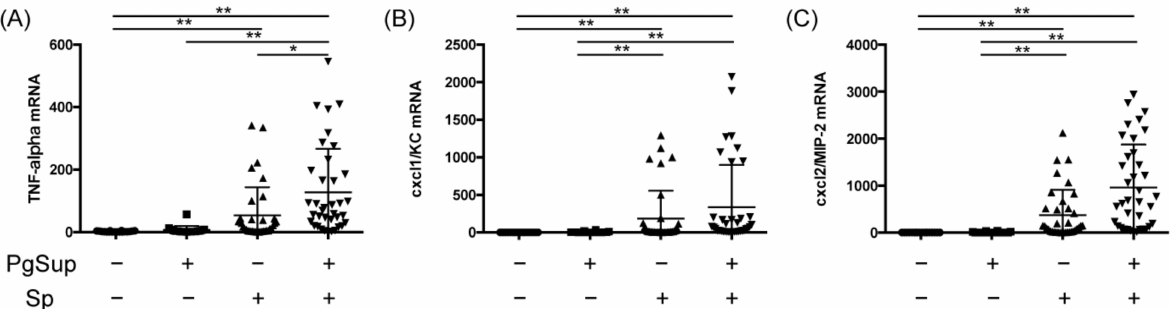
Figure 4. The mRNA expression of TNF- α , CXCL1 , and CXCL2 in Sp-infected mice inoculated with or without PgSup. Lung homogenates from each group were analyzed to compare ( A ) TNF- α , ( B ) CXCL1 , and ( C ) CXCL2 gene expression levels using qPCR. “+” indicates the presence of PgSup or Sp, and “ − ” indicates the absence of PgSup or Sp. Each group was analyzed by one-way ANOVA, and data are presented as the mean ± SD. Significant differences were analyzed using the Kruskal–Wallis test (* p < 0.05, ** p <